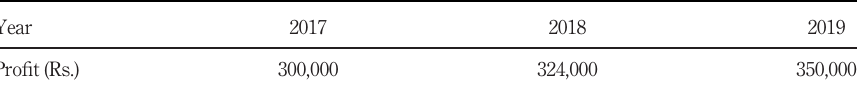
Table 8. 3 Years Net Pro fi t in Rs. of Balaji Mixture.